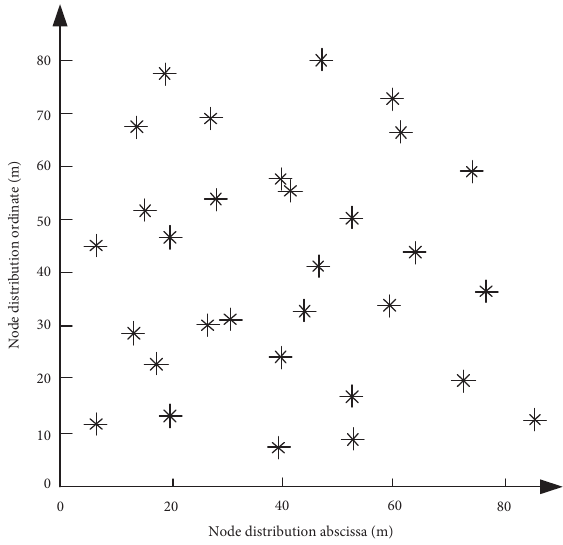
Figure 18: Experimental results of node initialization performance of this method.